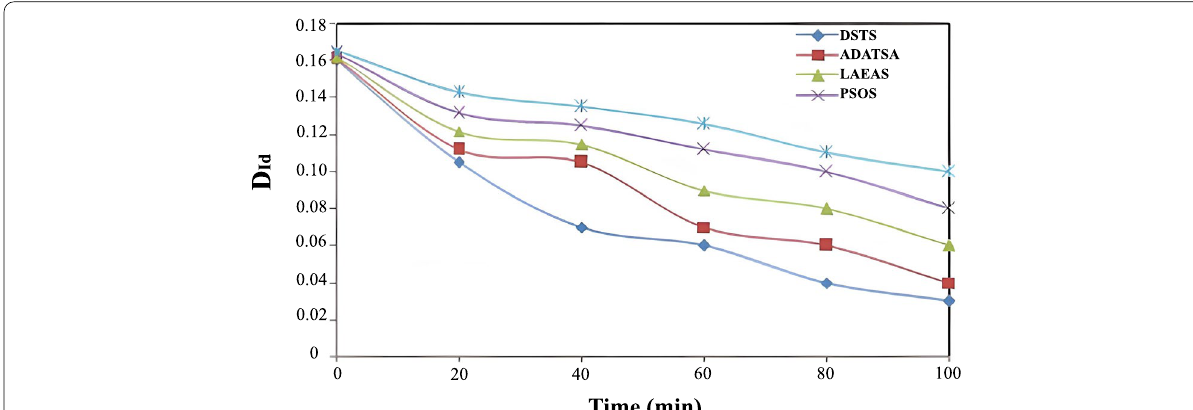
Fig. 6 Comparative analysis of resource imbalance degree (D Id ) with time (Task-3)